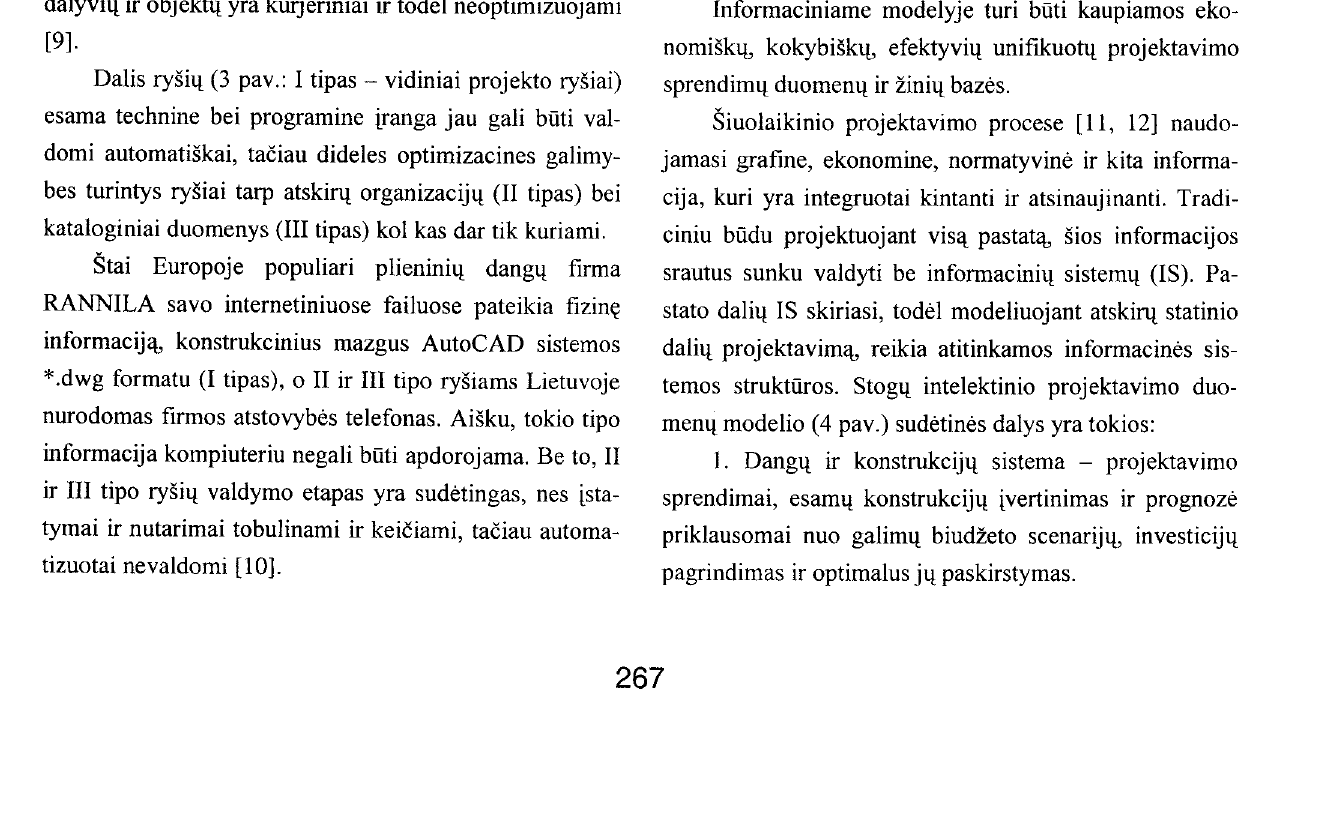
3.2. Modelio struktiira ir